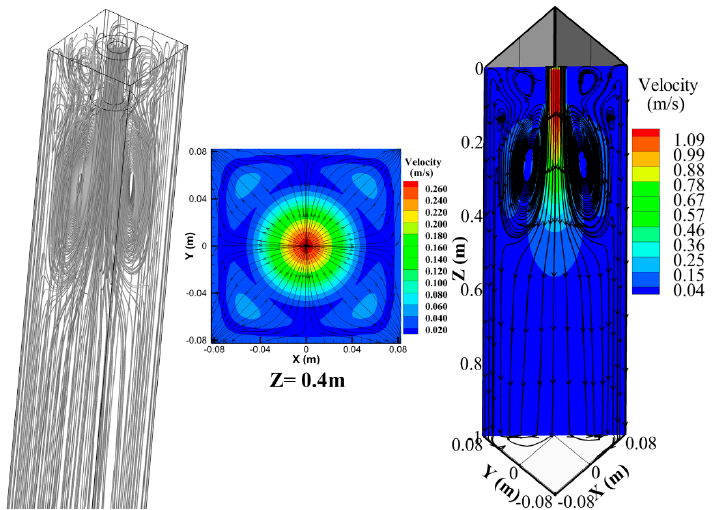
Figure 2. Streamline distribution and velocity contour in the mold.